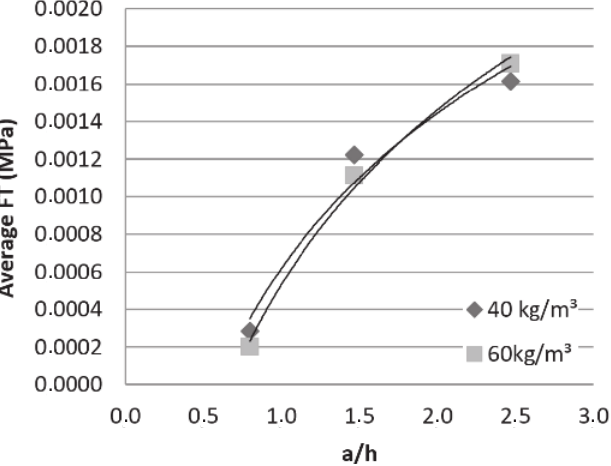
Average FT x ratio a/h for flexural toughness in each series